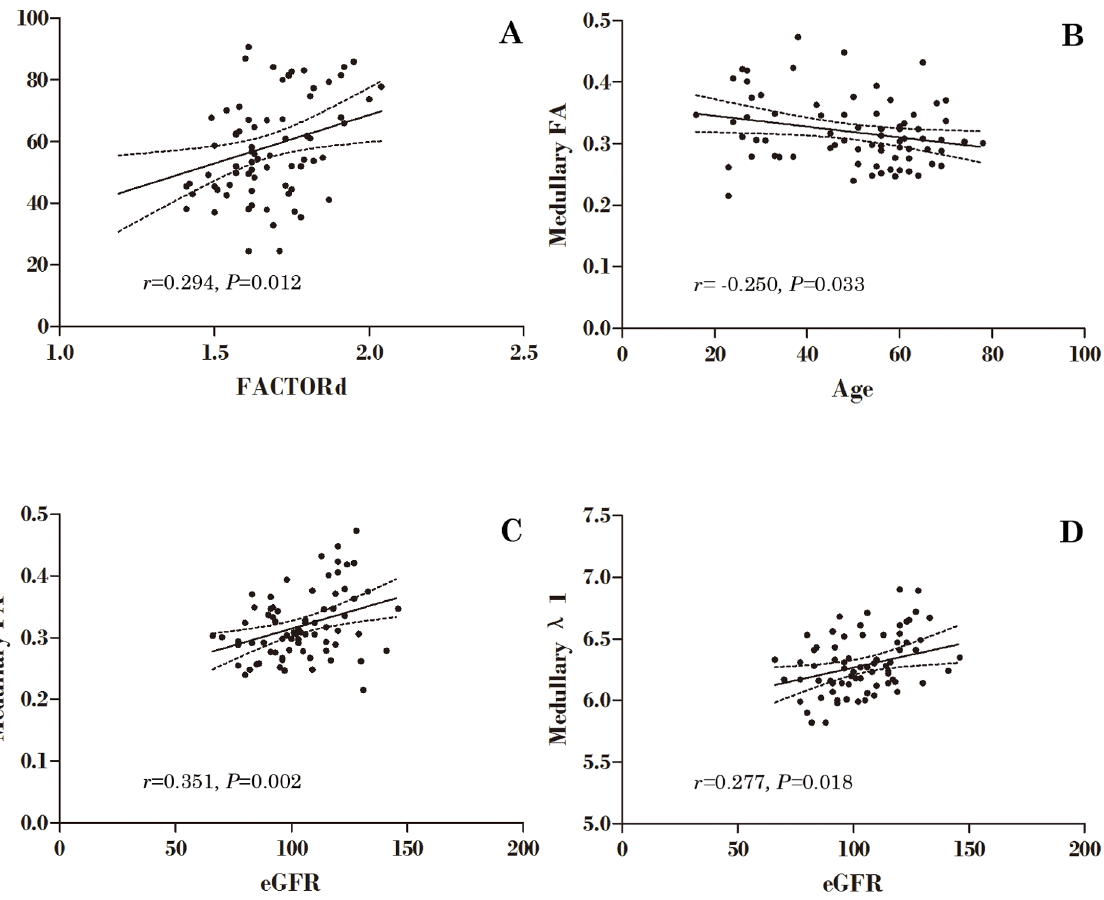
Figure 3. Correlation of renal cortical and medullary DTI parameters and anthropometric indices. (A) Anthropometric factor 3 versus DTI factor 3; (B) Age versus medullary FA value; (C) eGFR versus medullary FA value; (D) eGFR versus medullary l 1